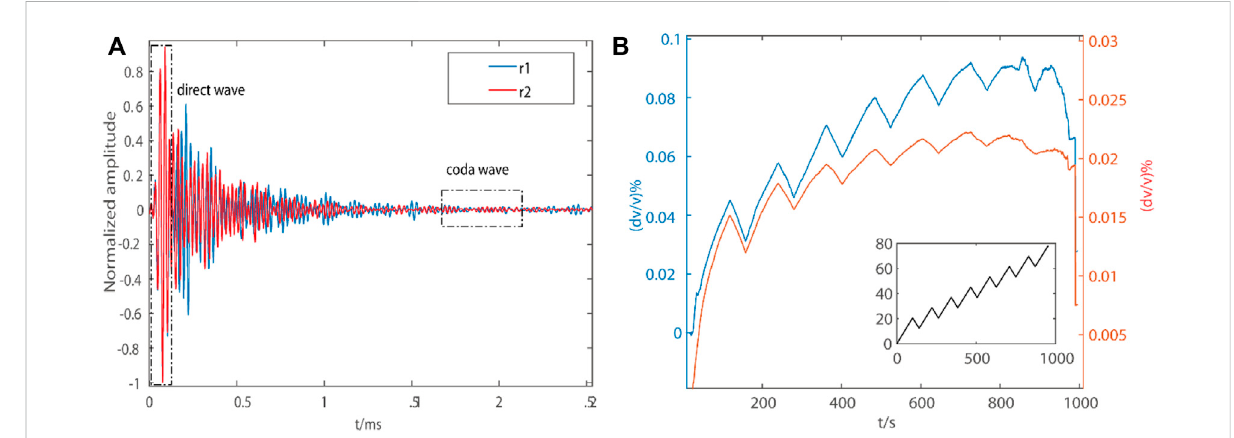
FIGURE 9 measurement window (A) and change of average relative wave velocity (B) .